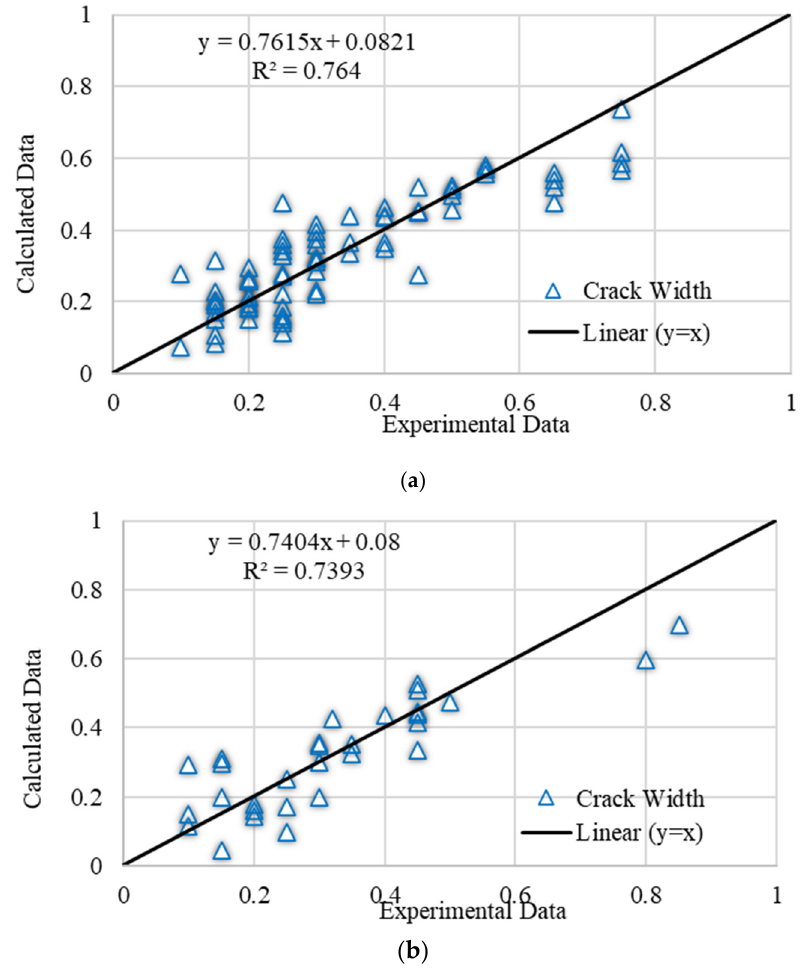
Figure 18. Experimental versus predicted values for predicting crack width using MLR: ( a ) Training data, ( b ) Testing data.